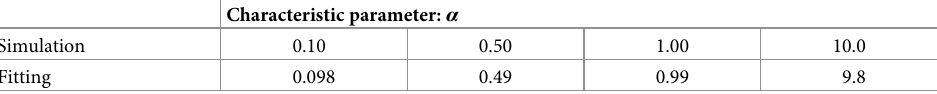
Table 2. Characteristic parameter α used for the numerical analysis and determined by the least-square method in Fig